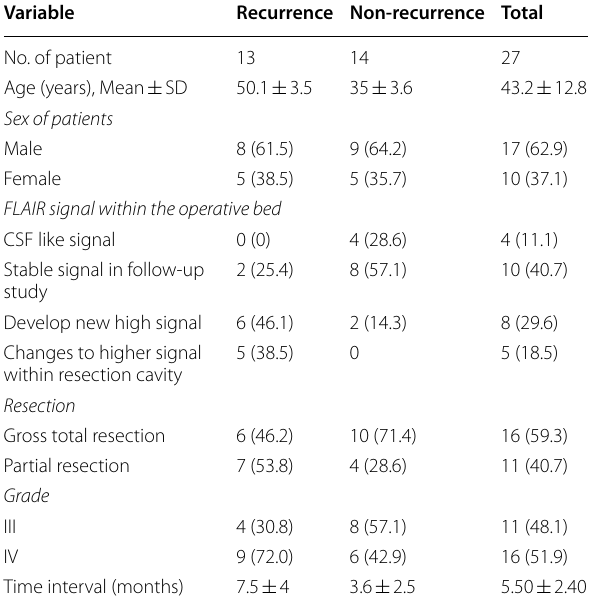
Table 2 Demographic and clinical data of the included